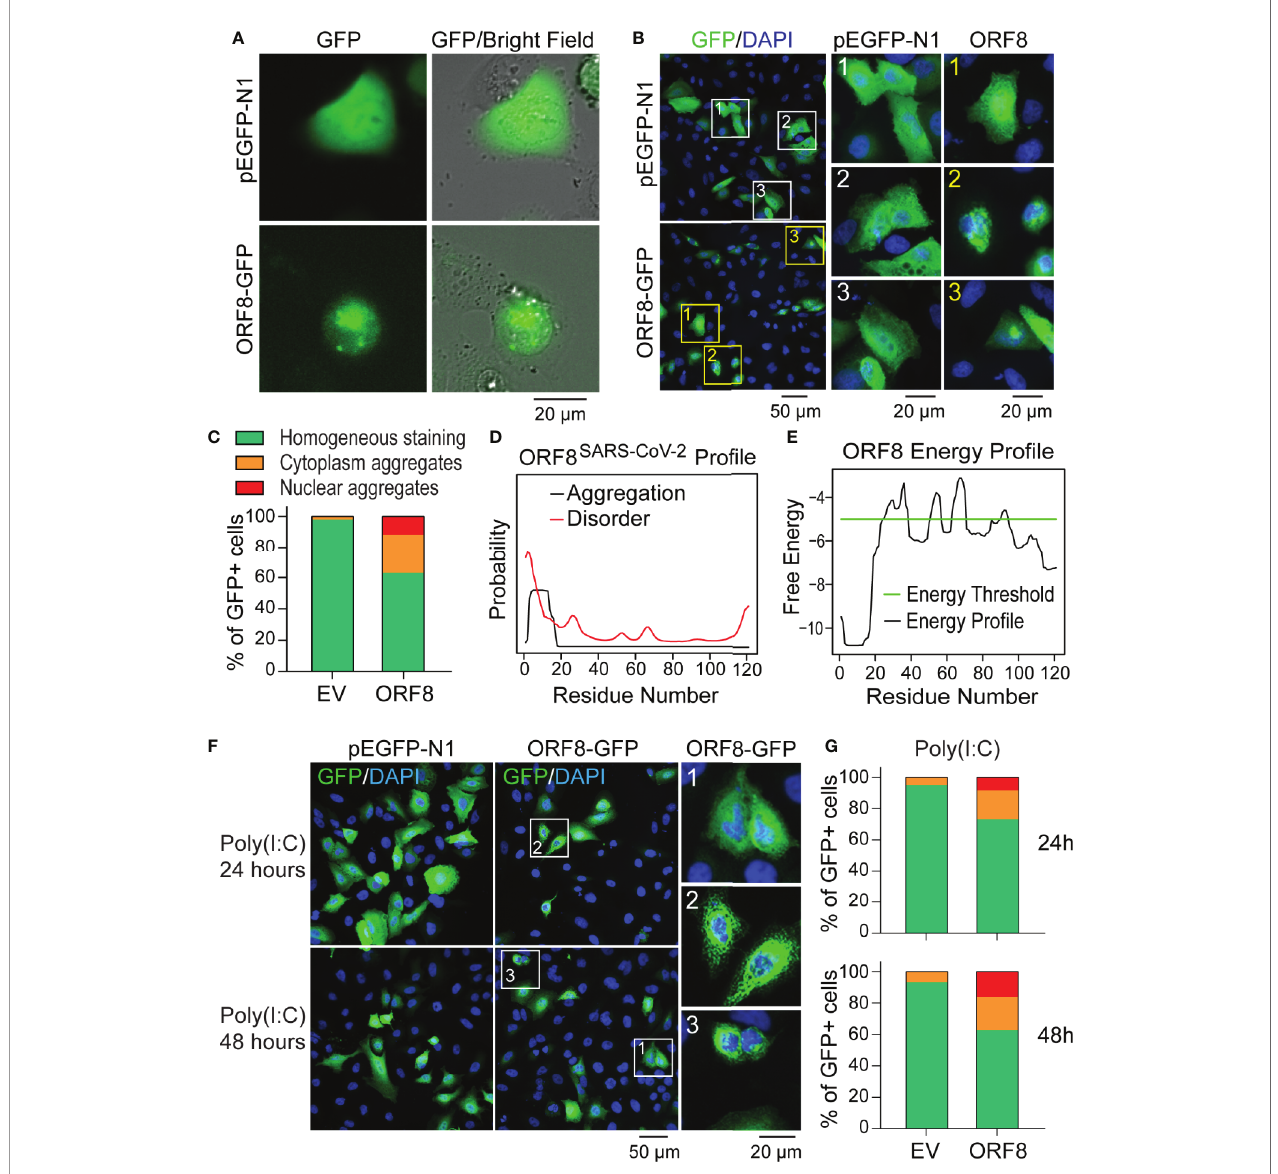
FIGURE 2 | ORF8 SARS-CoV-2 forms intracellular aggregates in human lung epithelial cells. (A-C) Aggregation of ORF8 SARS-CoV-2 protein in A549 cells viewed by fl uorescent microscopy. Human lung epithelial A549 cells were transfected with pEGFP-N1 (empty vector; EV) or pEGFP-ORF8 SARS-CoV-2 . After 24 h, fl uorescent microscopy was performed on either live cells (A) or paraformaldehyde- fi xed cells that were stained with anti-GFP antibody (B) . In the anti-GFP antibody-stained cells, quantitative analysis of nuclear-cytoplasmic distribution pattern of aggregated ORF8 SARS-CoV-2 was performed (C) . (D, E) Prediction of aggregation based on the ORF8 SARS-CoV-2 protein primary structure using the PASTA 2.0 algorithm (http://protein.bio.unipd.it/pasta2/). Aggregation disorder pro fi le (D) and aggregation- free energy pro fi le (E) showing that N-terminal residues 1-18 have the lowest aggregation free energy and thus is the most aggregation-stabilizing region underlying the propensity for ORF8 SARS-CoV-2 aggregates formation. (F, G) The intracellular distribution pattern of ORF8 SARS-CoV-2 aggregates is not affected by a poly (I:C)- induced in fl ammatory response. A549 cells were treated with poly (I:C) during transfection with pEGFP-N1 (EV) or pEGFP-ORF8 SARS-CoV-2 . After the indicated times, cells were fi xed with paraformaldehyde followed by immuno fl uorescent staining with anti-GFP antibody. The stained cells were viewed by fl uorescent microscopy (F) and processed for analysis of nuclear-cytoplasmic distribution pattern of ORF8 SARS-CoV-2 aggregates (G) . 1 indicates homogenous distribution; 2, cytoplasmic aggregates; and 3, nuclear